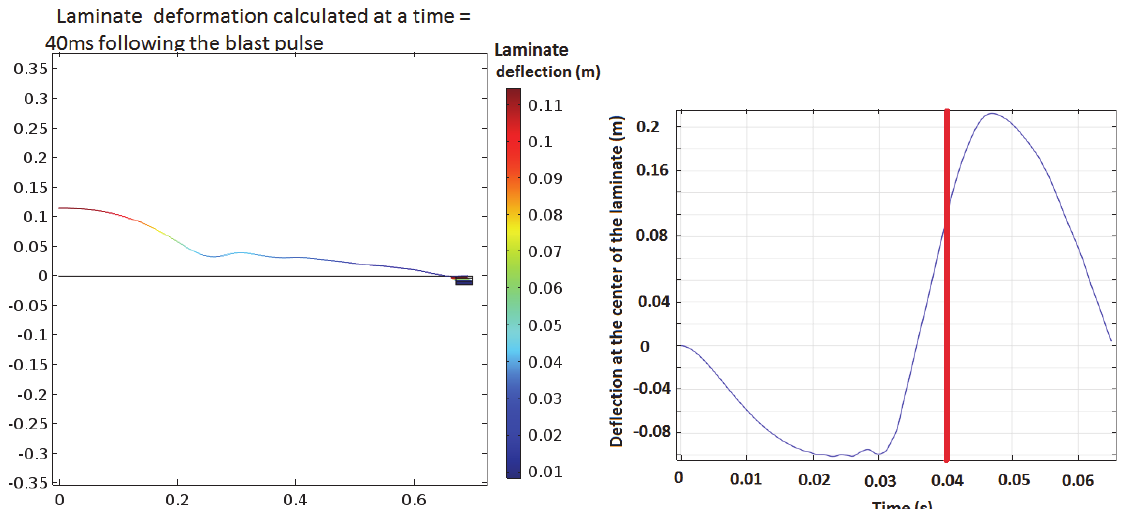
Fig. 5b: laminate deformation when moving towards the second peak of membrane deflection (t=40ms); pane bending is now directed towards the outside of the building.